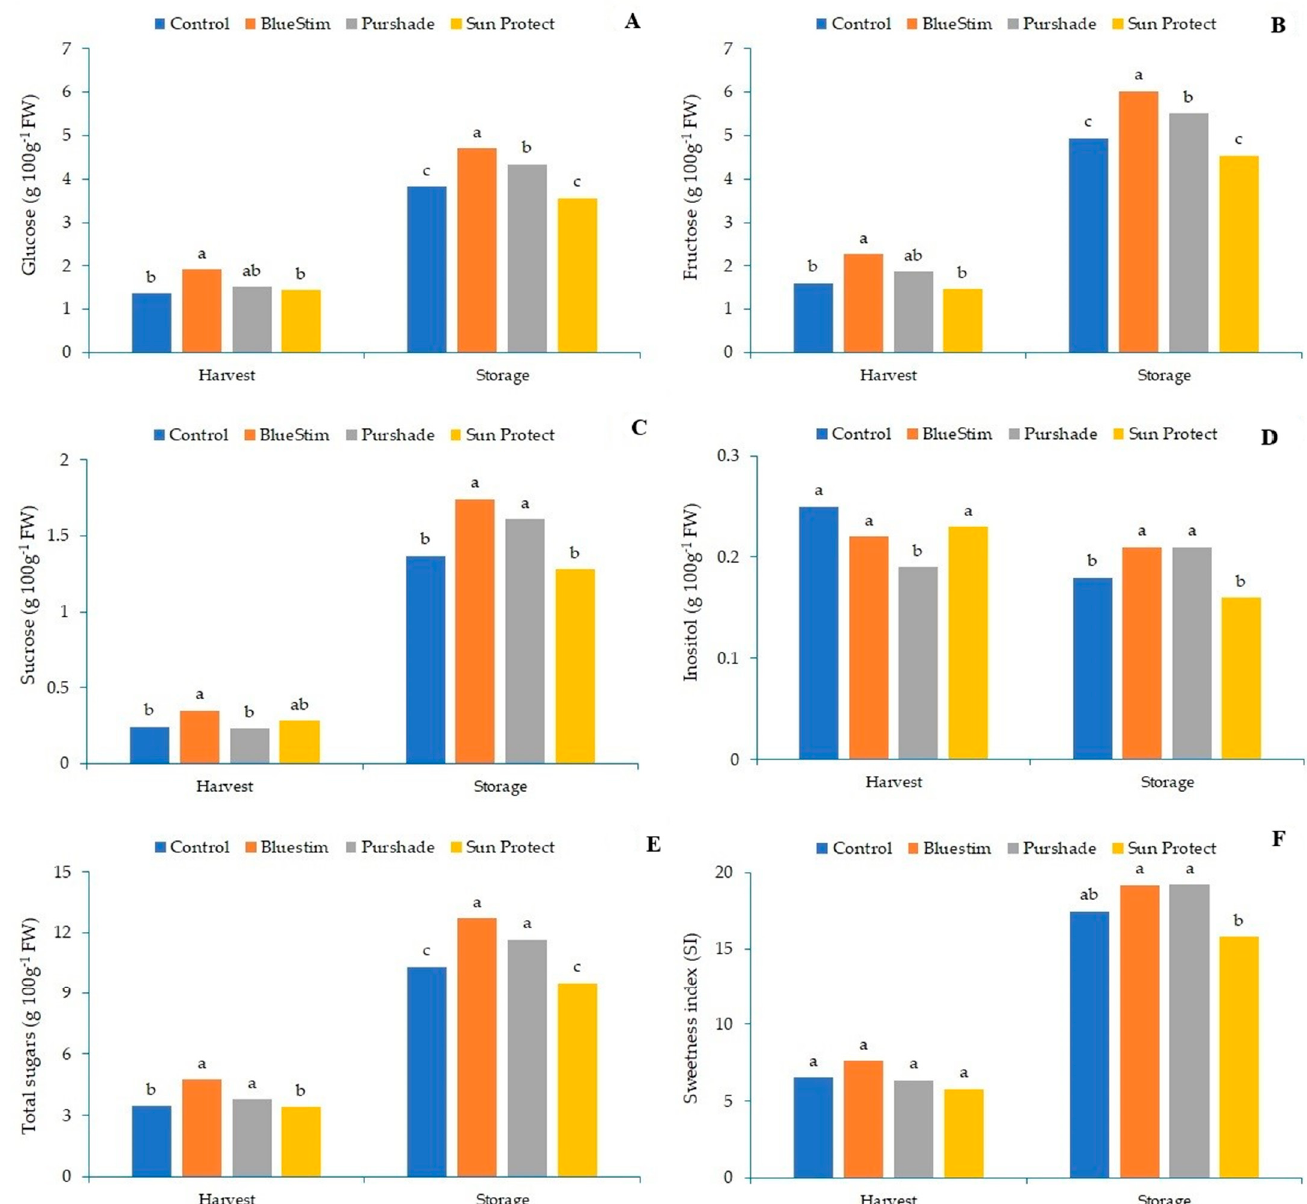
Figure 1. Effect of alleviating products on kiwifruit soluble sugars concentration (( A ), glucose, ( B ), fructose, ( C ), sucrose, ( D ), inositol, ( E ), total sugars) and sweetness index ( F ) at harvest and after storage at 0.5 ◦ C for 107 days. Treatment columns with the same lower case letter above, within the same production event (harvest or storage), do not significantly differ according to Tukey’s HSD multiple range test at α = 0.05.